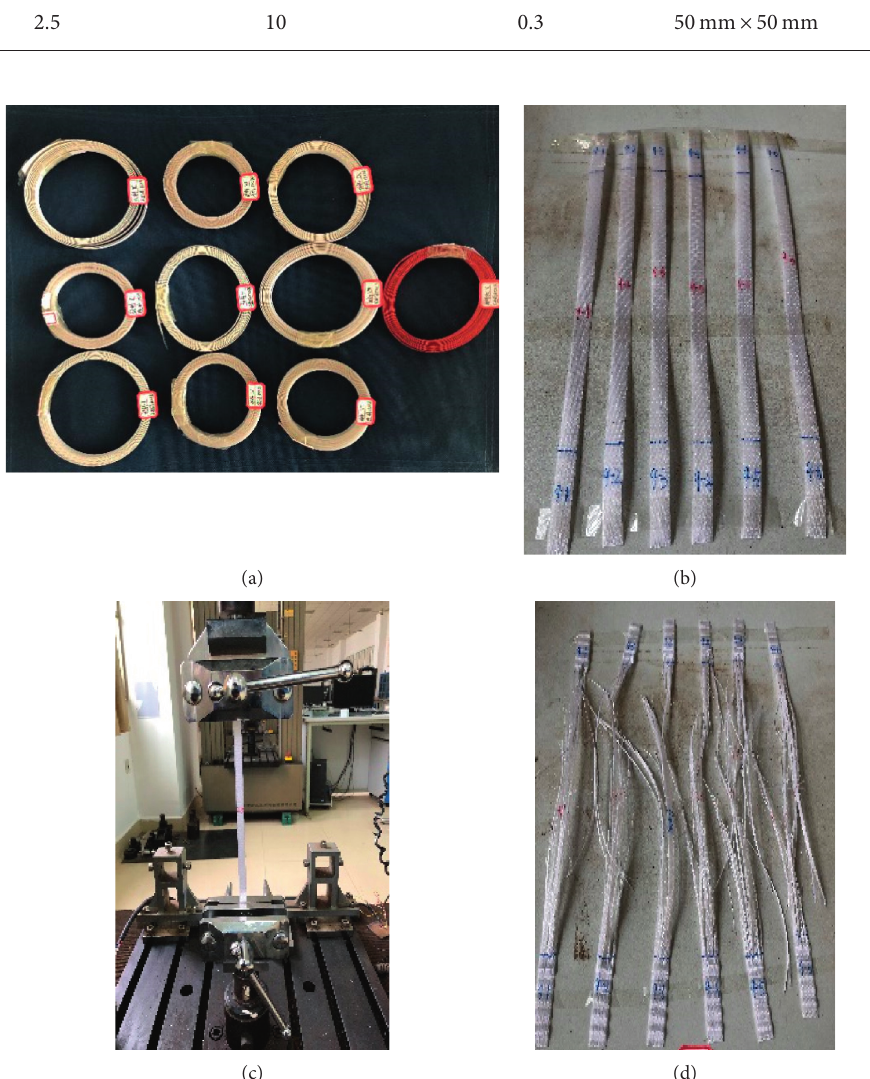
Figure 1: PP-bands tensile test. (a) 10 kinds of PP-band samples, (b) PP-band before test, (c) tensile mechanical properties test of packing strap, and (d) PP-band after